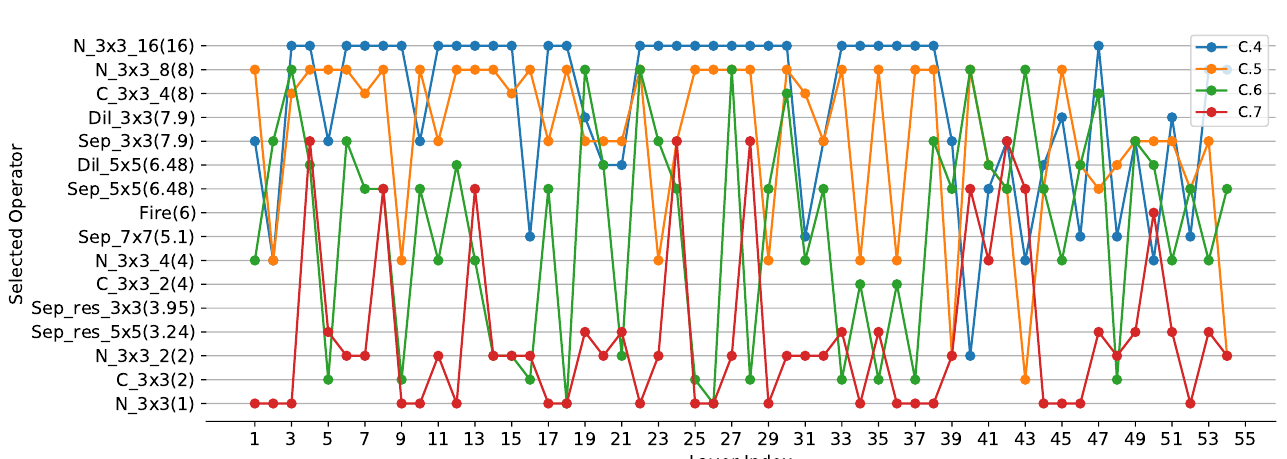
Figure 7. The operator of each layer in compressed ResNet56. The layers in the figure do not include the first convolutional layer and the last fully connected layer. The vertical axis has the same meanings as Figure